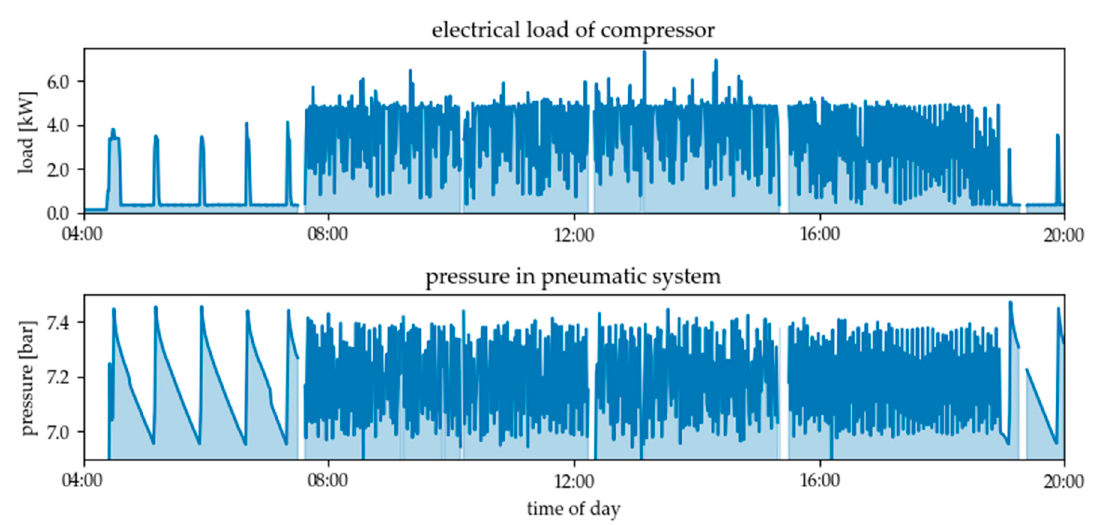
Figure 13. Electrical load profile of the compressed air generator and pressure in the network on 13.02.2019.